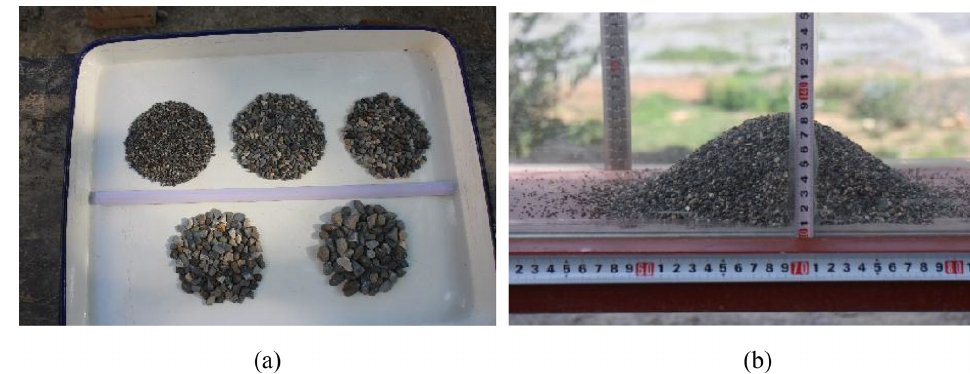
Figure 15. (a) Sand used for the granular flow tests. (b) Deposition tests for